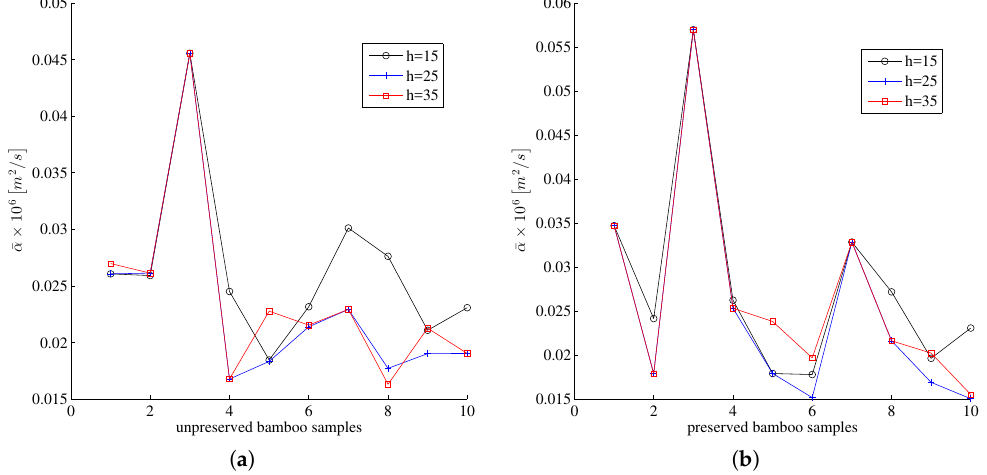
Figure 9. Thermal diffusivity estimates for unpreserved ( a ) and preserved ( b ) bamboo samples. The curves were obtained by dividing thermal conductivity and volumetric heat capacity curves displayed in Figure